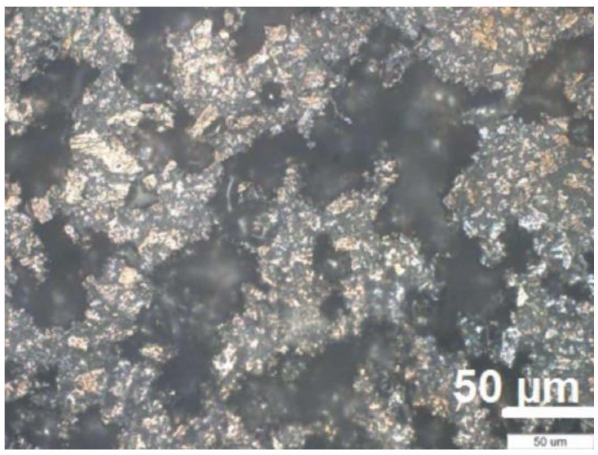
Figure 1. Green c.p. Ti sample, optical